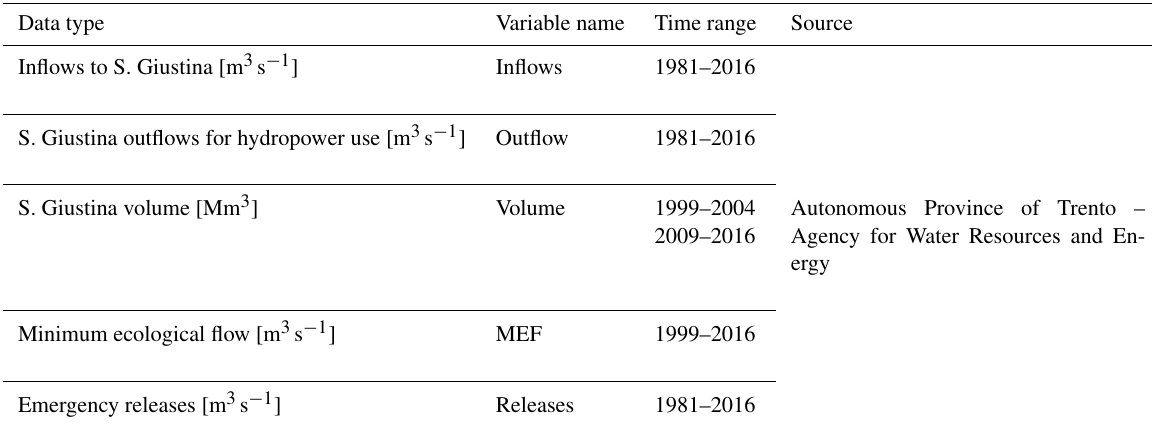
Table 1. Selected variables within the SDM (box 3 in Fig. 2) for the S. Giustina